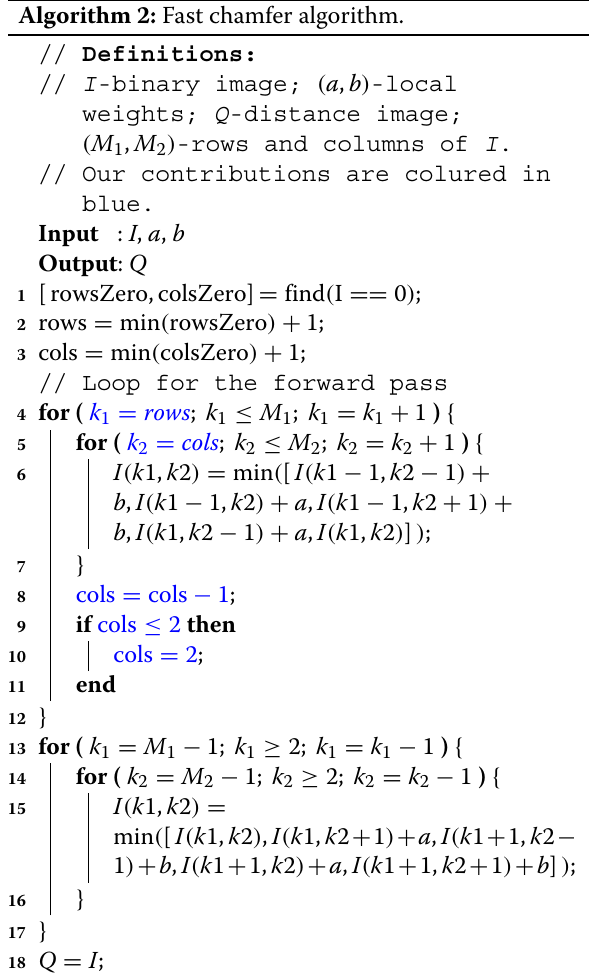
MSE, were used to compute the approximation